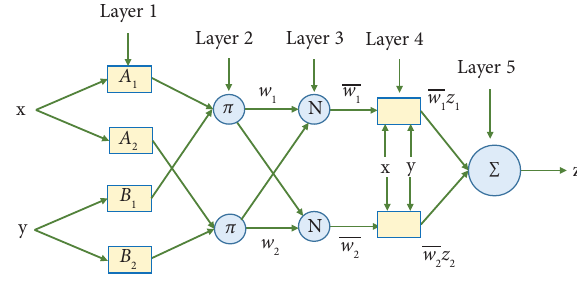
Figure 3: ANFIS model architecture.